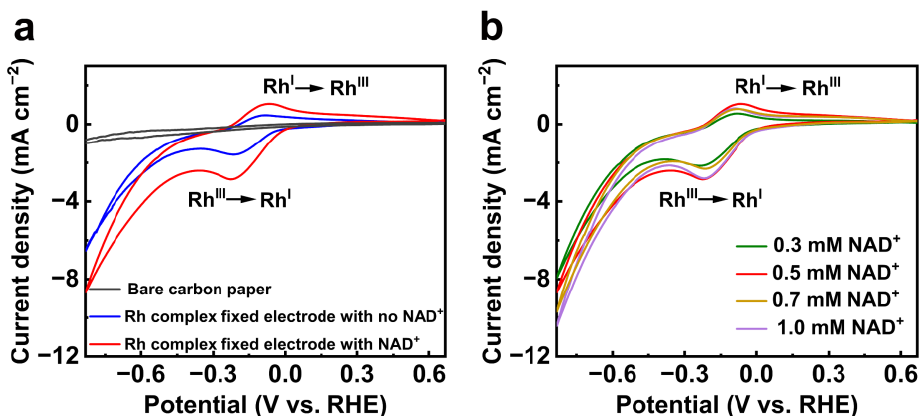
Figure 2. ( a ) CV curves of the bare carbon paper electrode and the Rh-complex fixed electrode with or without NAD + in PBS buffer; ( b ) CV curves of Rh-complex with different concentrations of NAD + . The scan rate was 20 mV s − 1 .